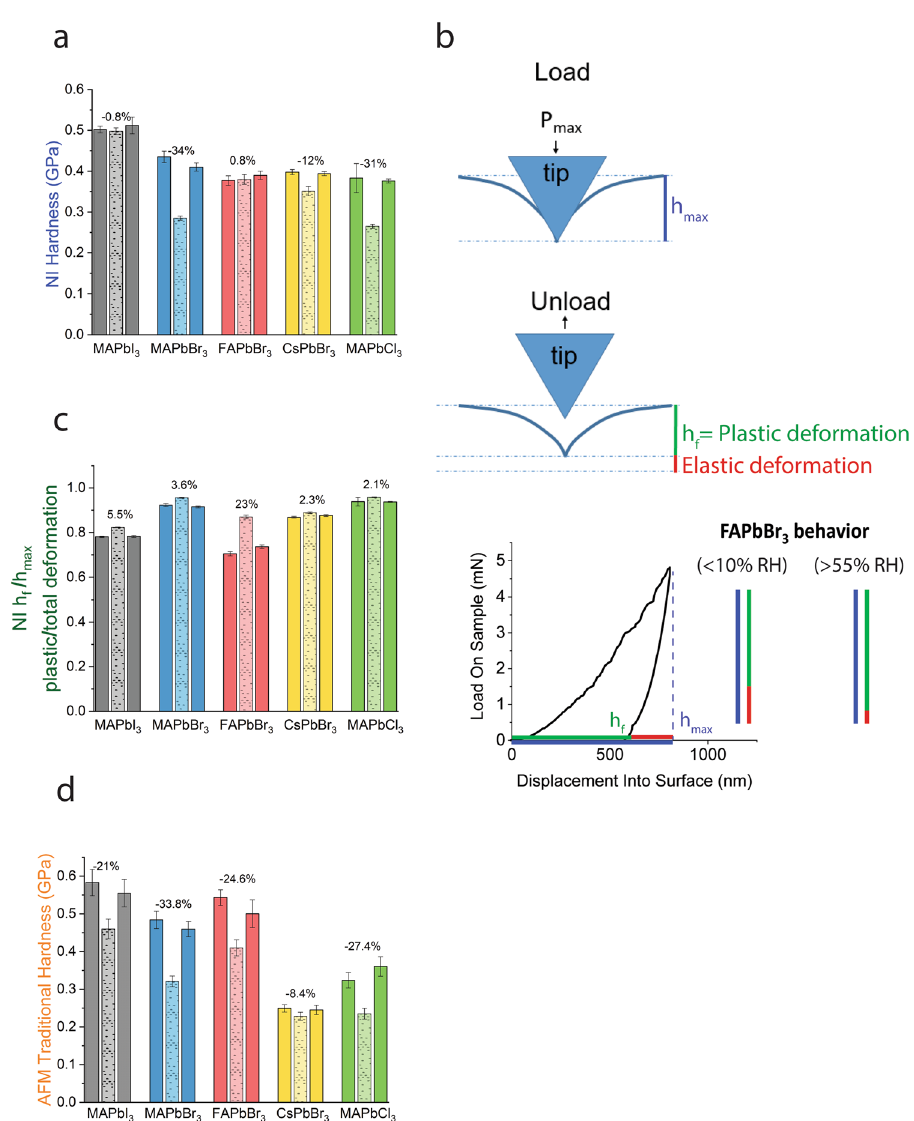
Fig. 5 Hardnesss measurements. a NI Hardness results. Solid bars represent measurements performed in the dry state; dotted bars represent measurements performed in the humid state. The percentage values here and in c – d represent the difference between dry and humid states for each set (see text and Fig. 2 caption). b Illustration of the indentation process, de fi ning h max and h f , and explaining the trade-off between the elastic and plastic deformation in FAPbBr 3. c Ratio h f /h max for each of the 5 crystals under the different humidity conditions. As shown schematically in b , h max is the depth at maximum load, and h f is the residual depth remaining after the indenter unloads to zero load. The ratio for each crystal increases slightly in the humid state, except for FAPbBr 3 , where the change is dramatic. d Traditional hardness (TH), calculated from the projected area of residual imprints in the AFM images for all 5 crystal types under dry and wet conditions as described in experimental section. Error bars in a,c, and d represent standard deviation in the